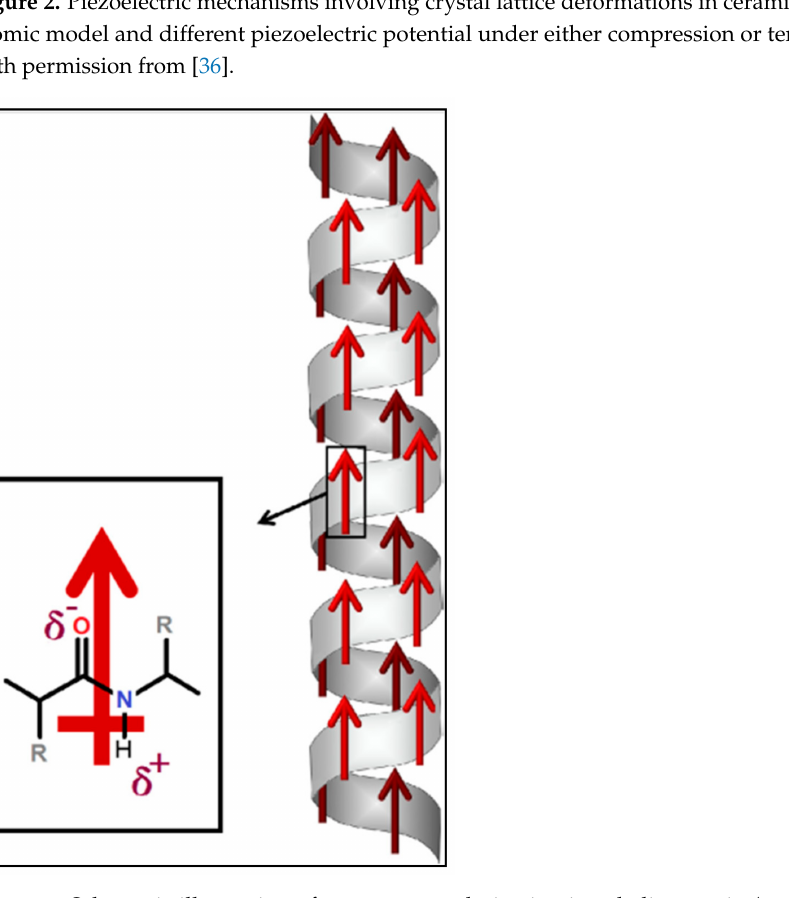
Figure 3. Schematic illustration of permanent polarization in α -helix protein (e.g., collagen). Red arrows demonstrate the direction of the dipole moment. Reprinted with permission from